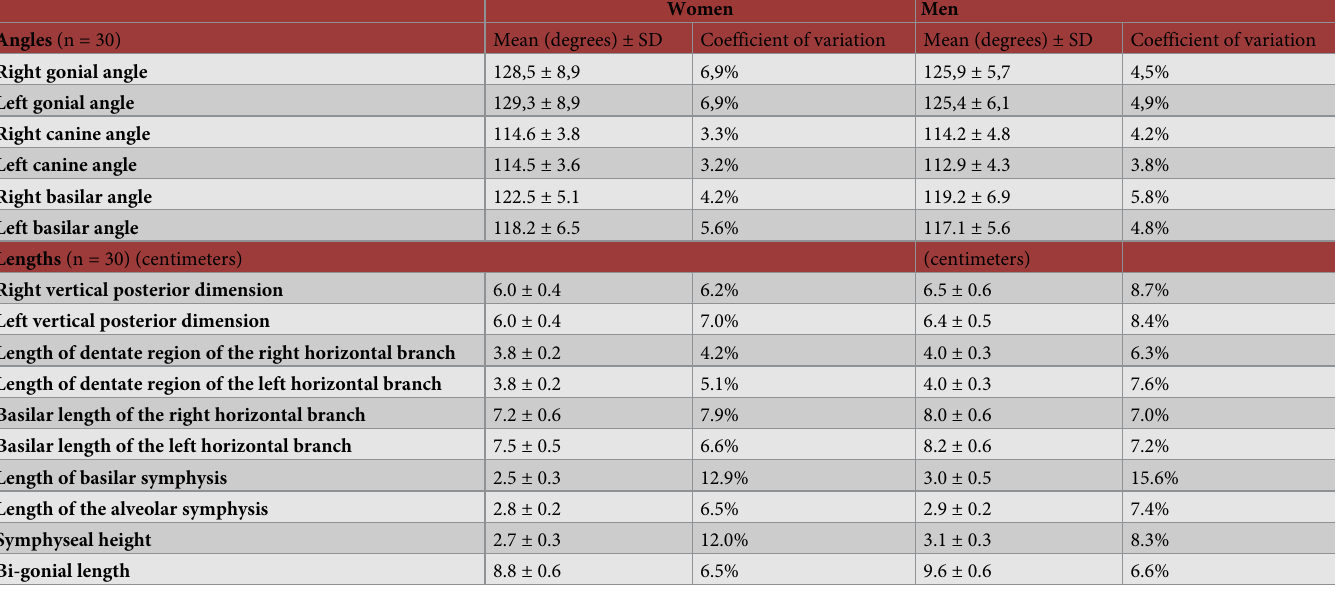
Table 2. Descriptive statistical analysis of the different angles and length